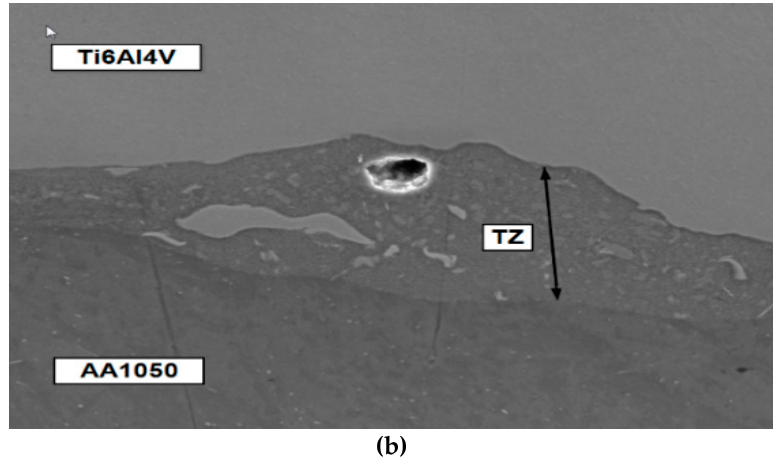
Figure 5. ( a ) inner layer and connecting zone of the base materials; ( b ) transition zone (TZ) between the AA1050 alloy and the Ti6Al4V alloy.